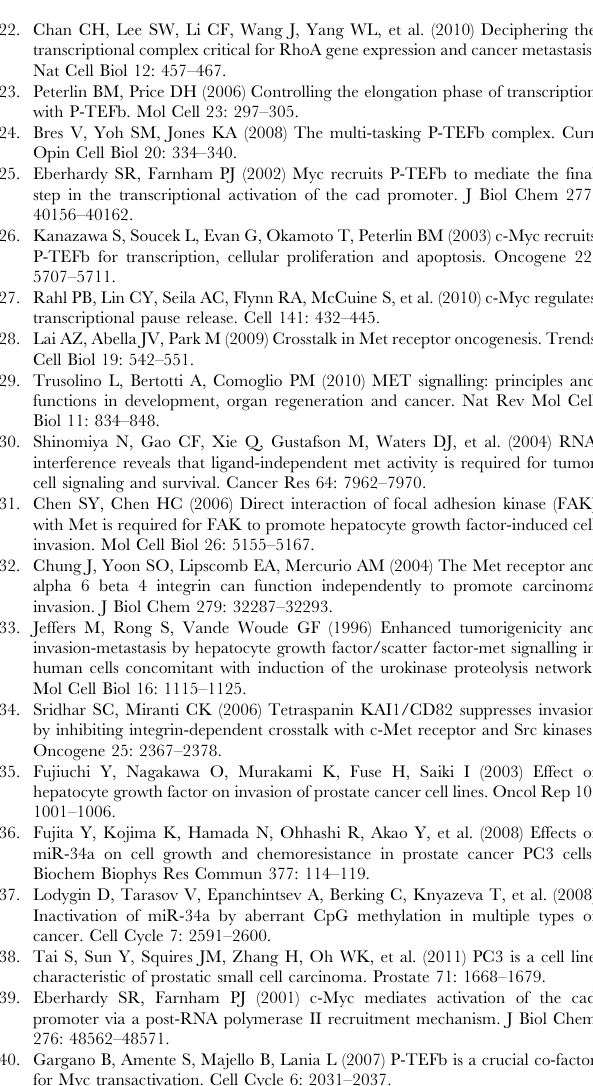
Figure S4 miR-34a target sequences of c-Met and c- Myc. (TIF) Table S1 Clinical data of laser capture microdissected (LCM) prostate cancer